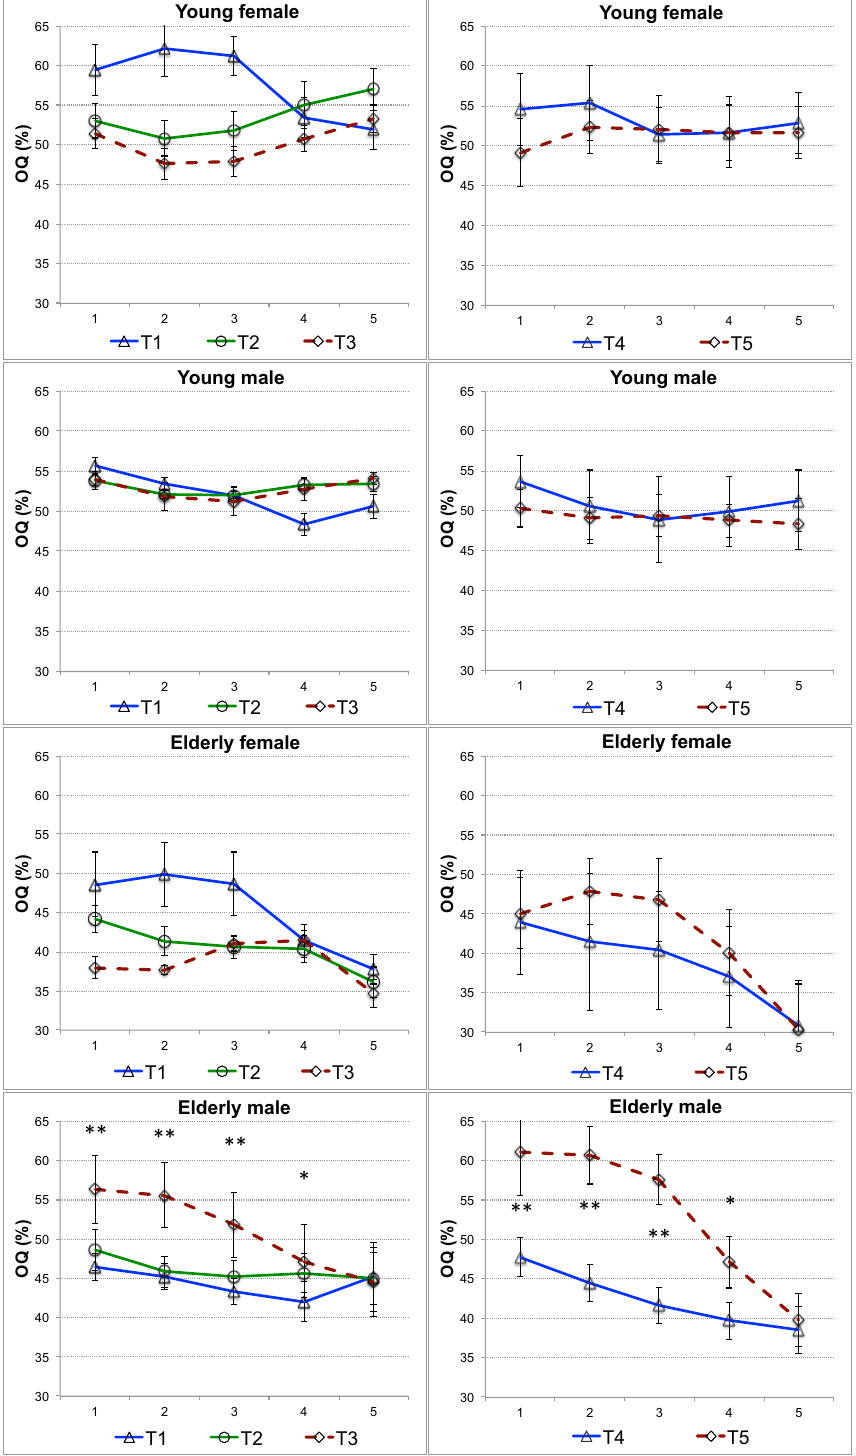
Figure 2: Averaged OQ contours according to tone, time point, and speaker